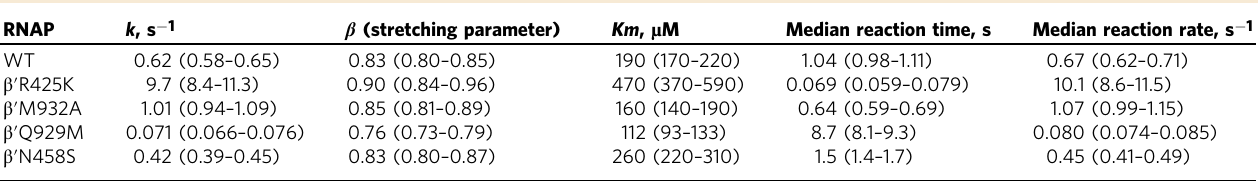
Table 2 Kinetic parameters for the 2 ′ dGTP utilization by E. coli RNAPs ( fi t to equation 1). RNAP k , s − 1